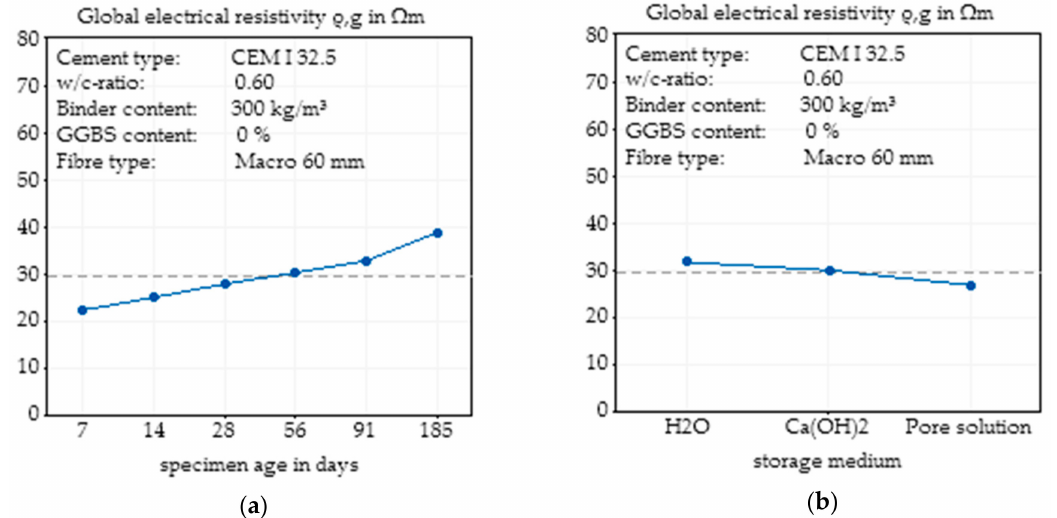
Figure 15. Main effect plot of the concrete age on the global electrical resistivity of SFRC calculated by Minitab based on nine specimens ( a ) and main effect plot of the storage conditions on the global electrical resistivity of SFRC calculated by Minitab based on nine specimens ( b